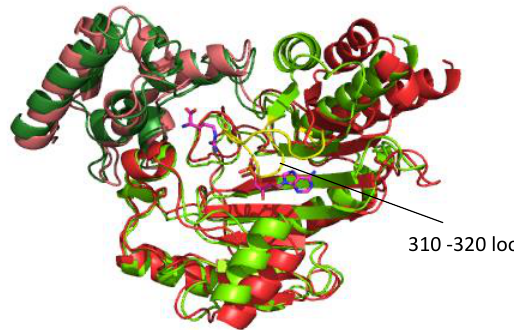
Figure 2. Crystallographic structure of the apo Rs AK. ( A ) cartoon representation of Rs AK with the N -terminal domain in green and the C -terminal in grey. ( B ) representative electron density of the 2F o -Fc map at 1 σ. ( C ) representation of the arginine binding site. Interacting residues are shown as sticks. After repeated unsuccessful crystallization trials using kits Crystal Screen 1, 2, and Index (Hampton Research) to obtain an experimental model of the closed conformation